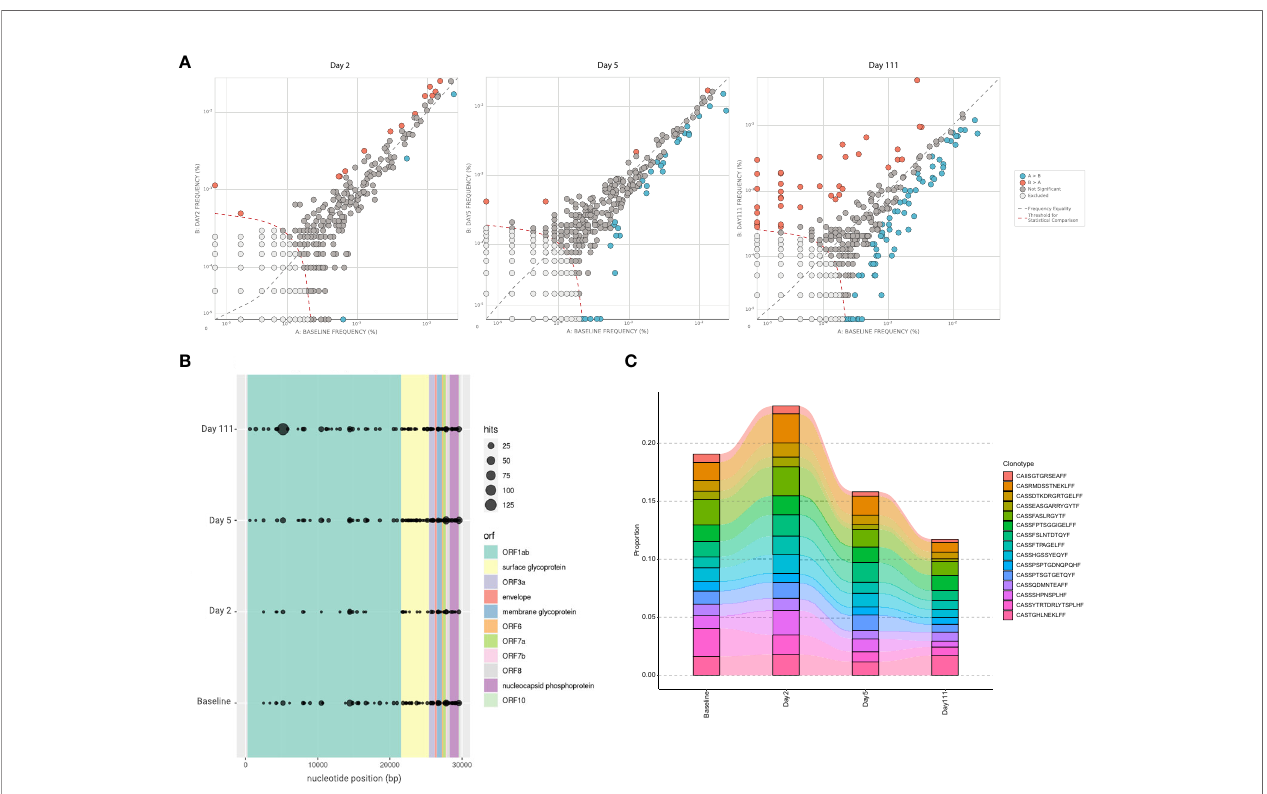
FIGURE 3 | T cell repertoire sequencing of patient at study time points. (A) Differential abundance analysis comparing clonotypes that have signi fi cantly increased or decreased in frequency across baseline and post-infection Day 2, Day 5, and Day 111. This is based on a beta-binomial model where normal repertoire changes in healthy adults over time are accounted for while measuring clonal expansion. (B) Locations on the SARS-CoV-2 genome where TCR binding has likely occurring; different colours specify open reading frame, and size of dots indicate number of TCR b rearrangements associated with SARS-CoV-2 at a particular position. Screening was performed based on the ImmuneCODE database (Adaptive Biotechnologies). (C) Changes in frequencies of the 15 most frequently observed TCR clonotypes, relative to total TCR repertoire, across baseline and post-infection day 2, 5, and